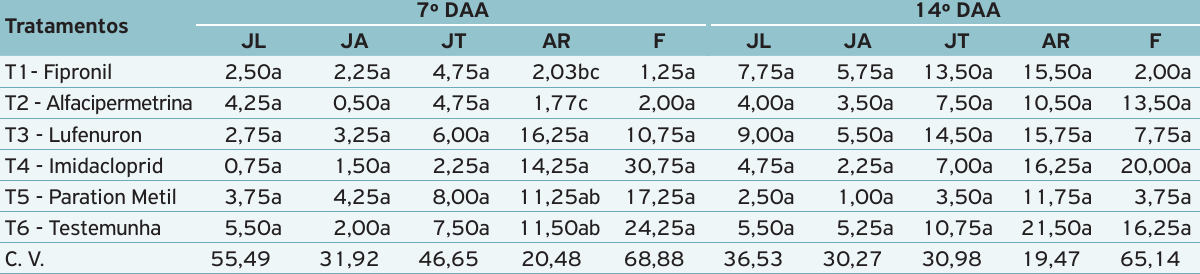
Tabela 2. Número médio de larvas, adultos e total de joaninhas, aranhas e formigas coletados na cultura do algodão, no sétimo e décimo quarto dias após a aplicação (DAA) de inseticidas. Malhada (BA)